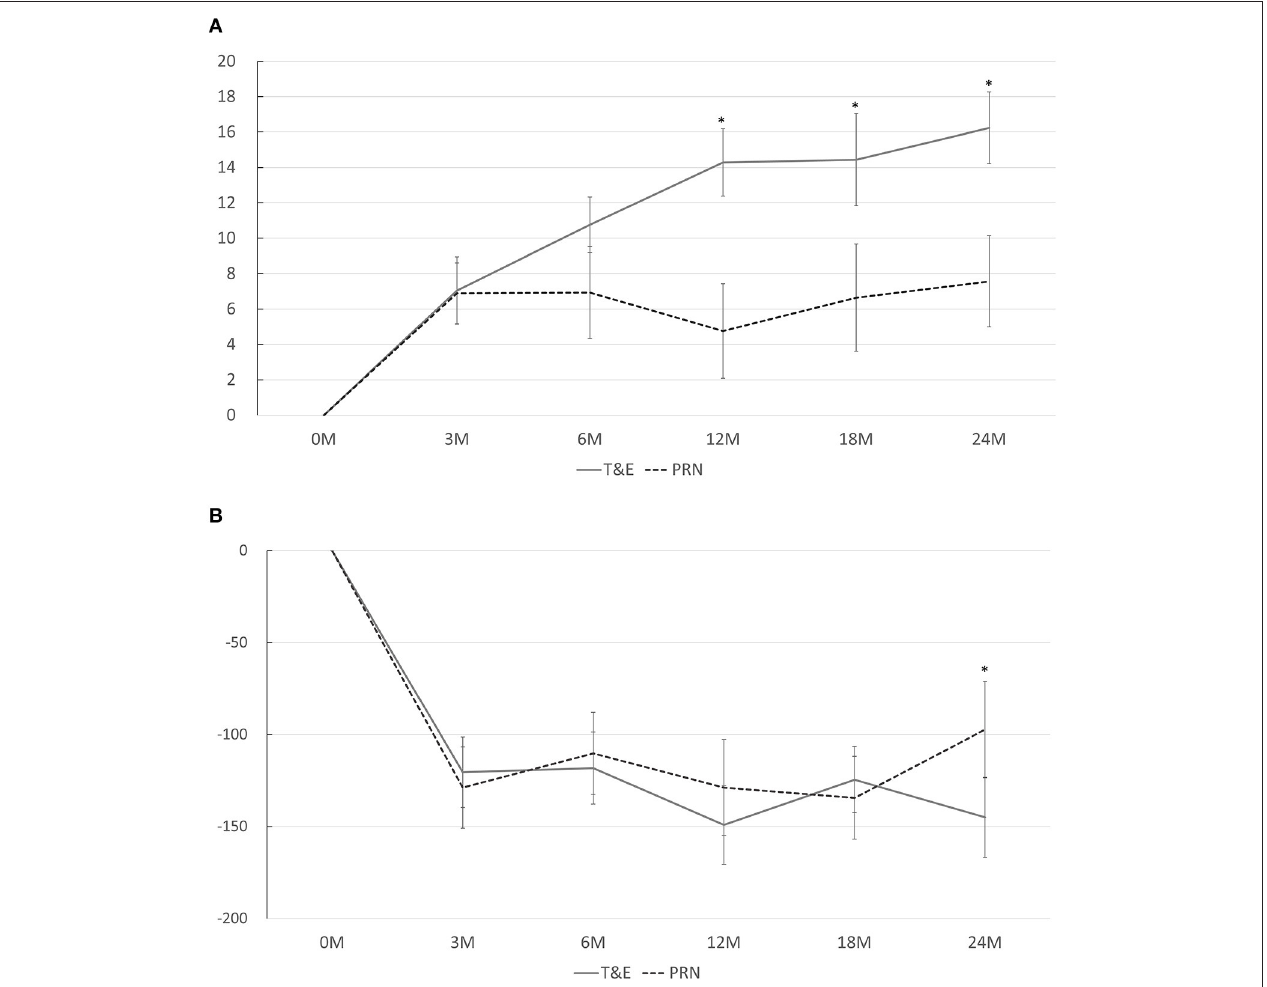
FIGURE 1 | (A) Mean changes in the best-corrected visual acuity from baseline at different time points. A significant difference between the T&E and PRN groups is found at 12, 18, and 24 months. (B) Mean changes in the central foveal thickness from baseline at different time points. A significant difference between the T&E and PRN groups is found at 24 months. T&E, treat-and-extend; PRN, pro re nata. * p < 0.05.